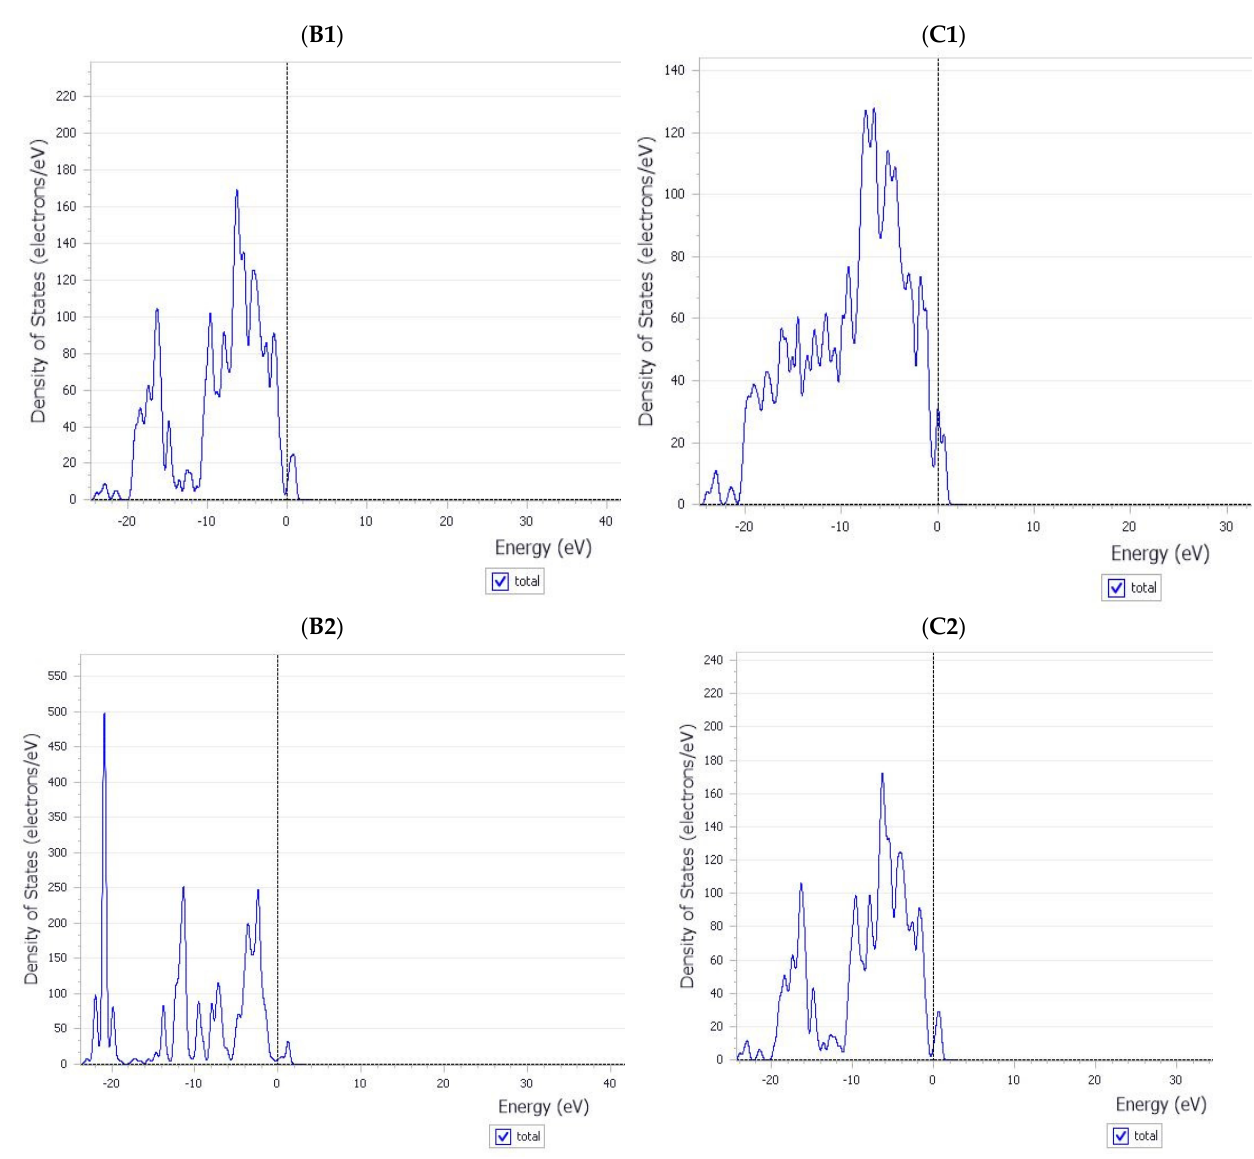
Figure 3. The density of states (DOS) of the mycolactone- nanotube complexes calculated at the DFT level. ( B1 )—Mycolactone on a center of BNNT’s surface, ( B2 )—Mycolactone on the far end of the BNNT’s surface, ( C1 )—Mycolactone on the center of the CNT’s surface, and ( C2 )—Mycolactone on the far end of the CNT’s surface.